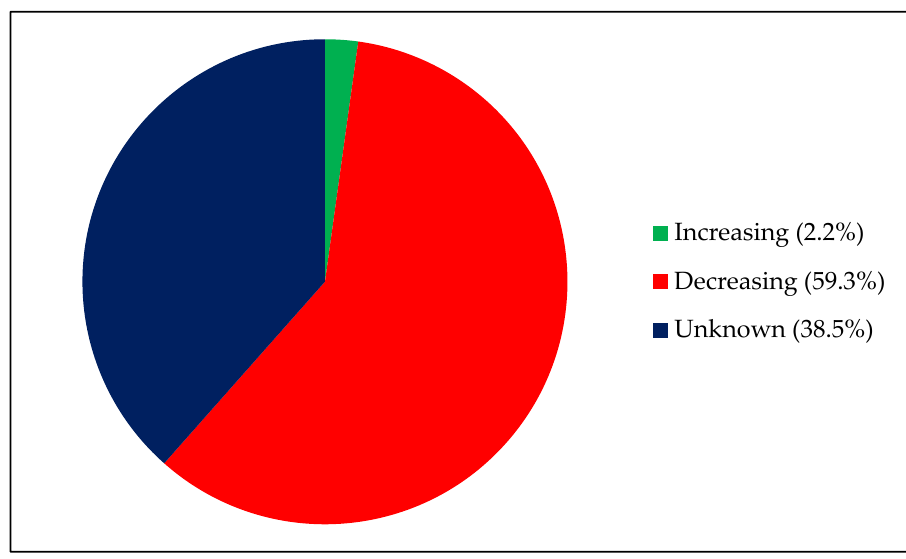
Figure 9. National fish population trend.